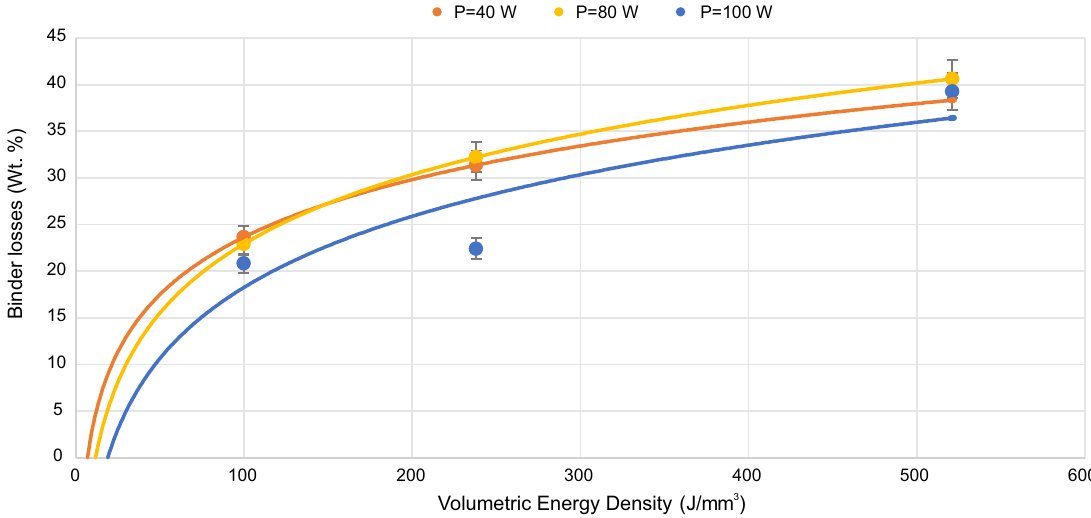
Figure 11. Co binder volume vs. volumetric energy density (VED) applied in Selective Laser Melting (SLM). As partial pressure of gas increases with the volume of evaporated material, round pores form at higher energies and take up a larger volume. As more binder evaporates, the cemented carbide becomes more brittle which, along with temperature gradients, contributes to cracking at higher